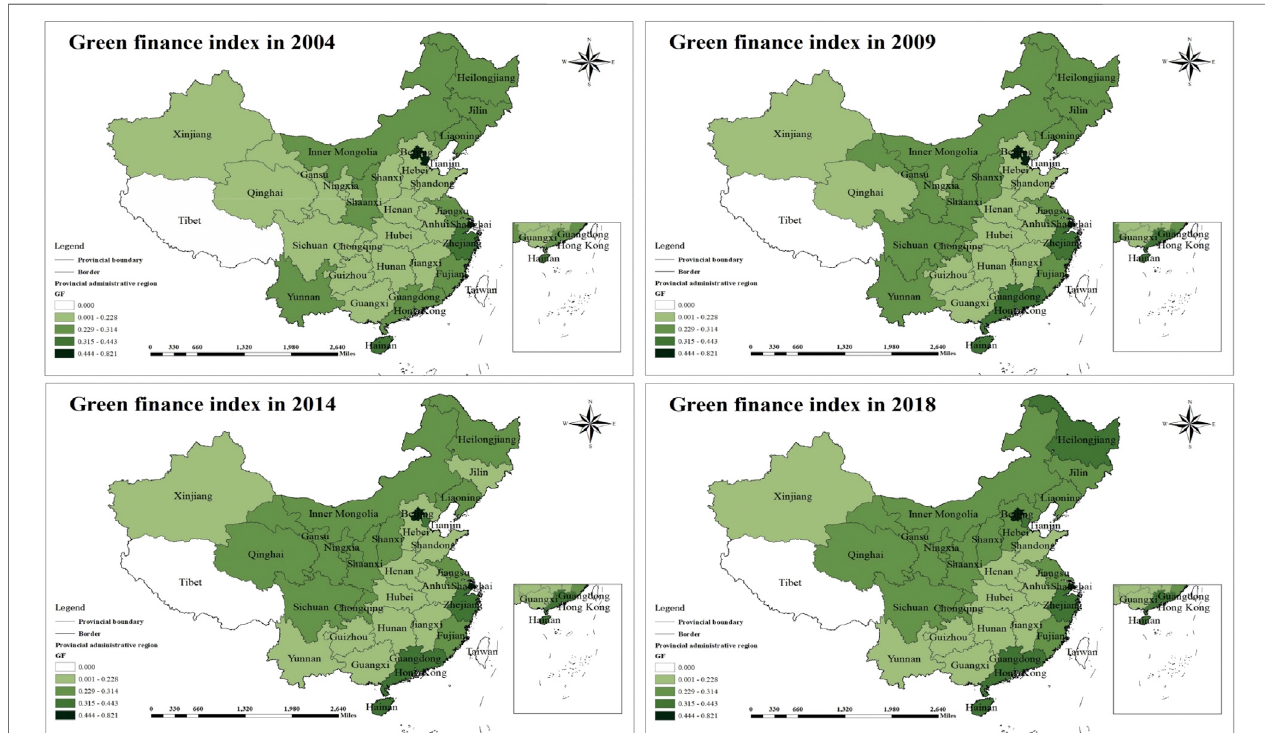
FIGURE 3 | Spatial distribution of the green fi nance index in selected years.